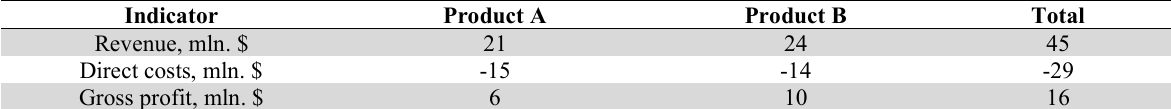
Enterprise’s financial